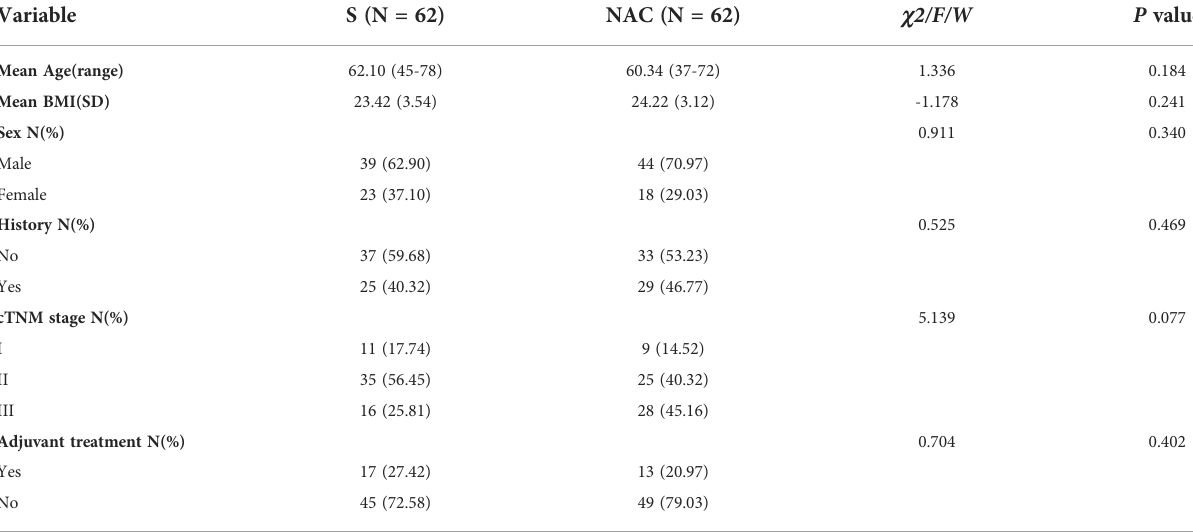
TABLE 1 Baseline demograpic and clinical characteristics of esophageal carcinoma patients after PMS.